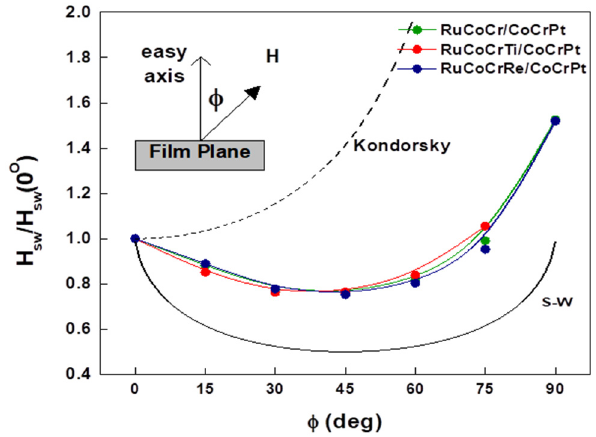
Figure 8. Angular dependence of the normalized switching field (H sw / H sw,0 ◦ ) as a function of the CoCrPt / y / NiW / NiTa, y = RuCoCrX (X = Ti, Re) films; the curve of the reference sample (RuCoCr intermediate layer) is also reported together with the theoretical curves corresponding to the Stoner-Wohlfarth and Kondorsky switching models.